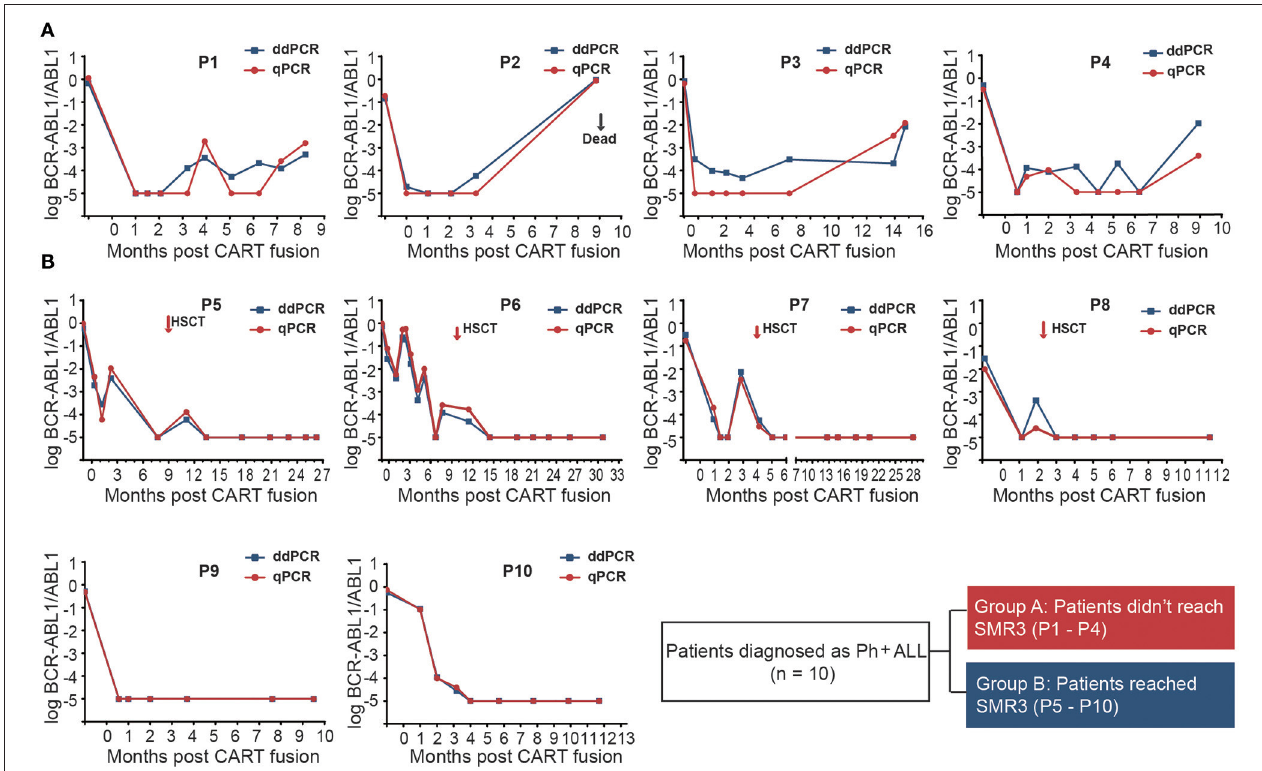
FIGURE 2 | Periodic MRD monitoring of 10 patients with chimeric antigen receptor T-cell (CAR-T) therapy and with Ph + ALL by ddPCR and qPCR. The x-axis represents the follow-up time from the initial days of CAR-T infusion and the y-axis represents log (BCR-ABL/ABL). The result < 10 − 5 was defined as negative. (A) Patients (P1–P4) without SMR3 relapsed when they received no extra-specific treatment except CAR-T regimen. It was noted that ddPCR could identify positive recurrence even several months before qPCR testing in patient P3; (B) Patients with the SMR3 indicator could maintain CR for longer time. The cases such as P9